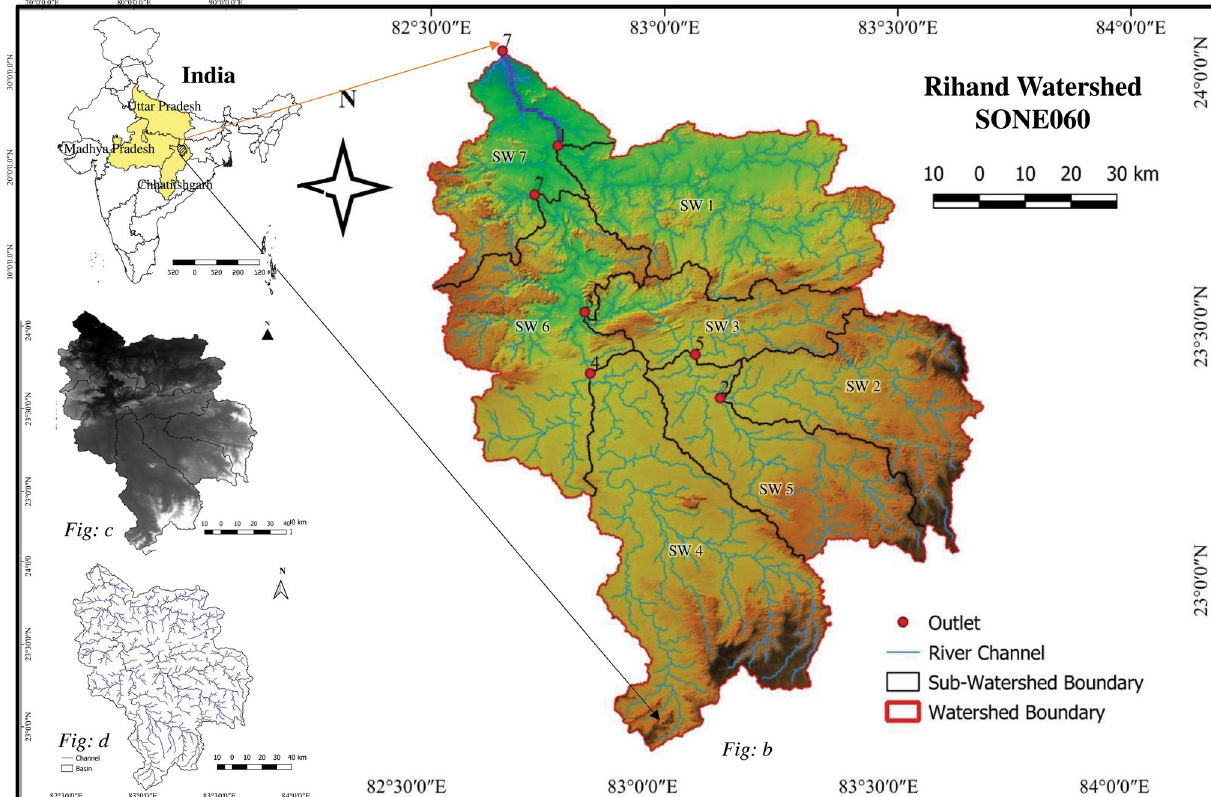
Fig. 1 a , b Location of Rihand watersheds c DEM; d